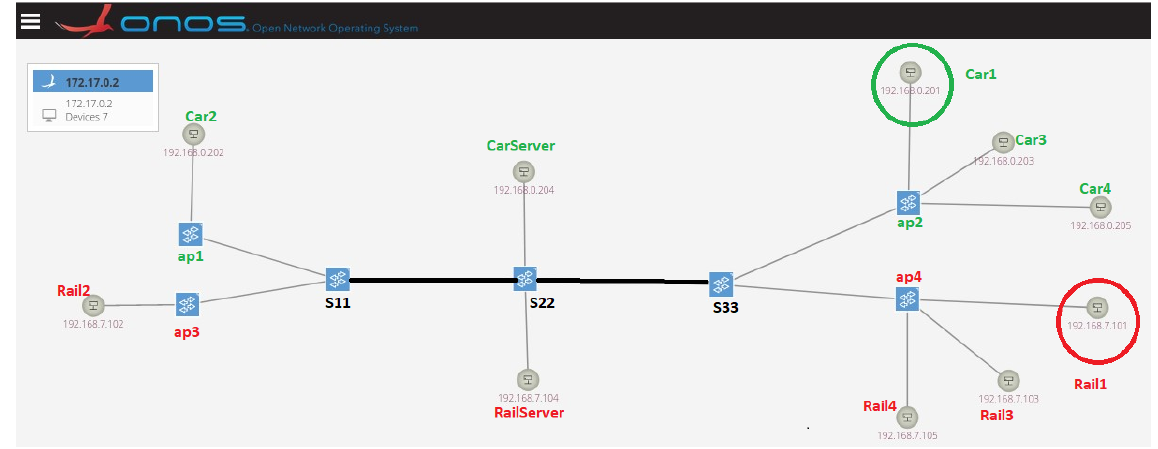
Figure 14. Handover scenario for S2(5/6)1 topology: ONOS screenshot.